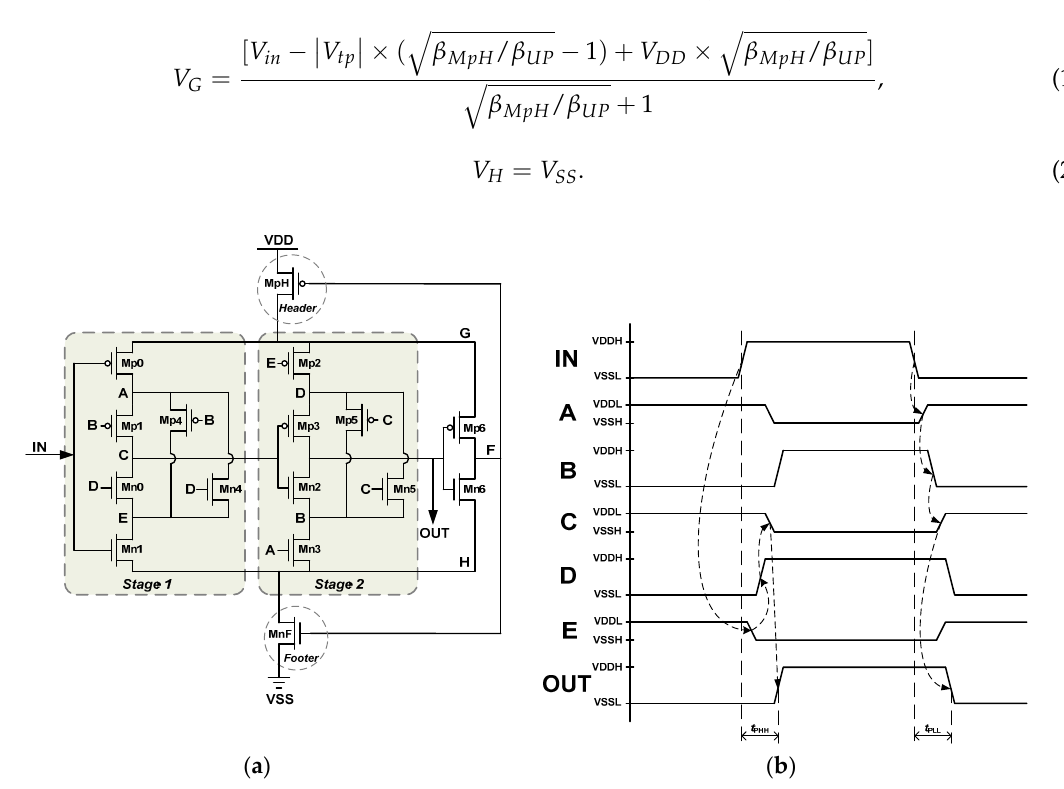
Figure 3. ( a ) The general circuit configurations of the proposed hysteresis delay cell (HDC); ( b ) The operating timing diagrams of the proposed HDC.